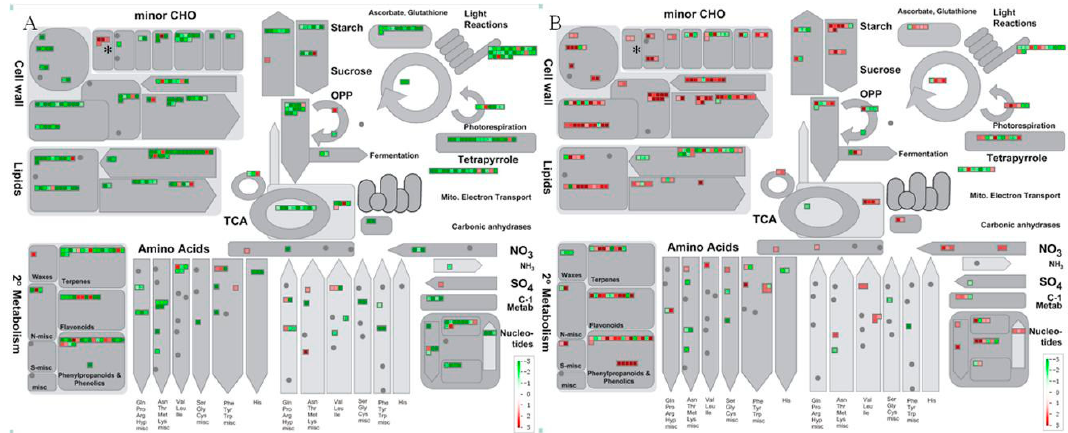
assigned a specific ID in Mapman; DEG, differentially expressed gene.